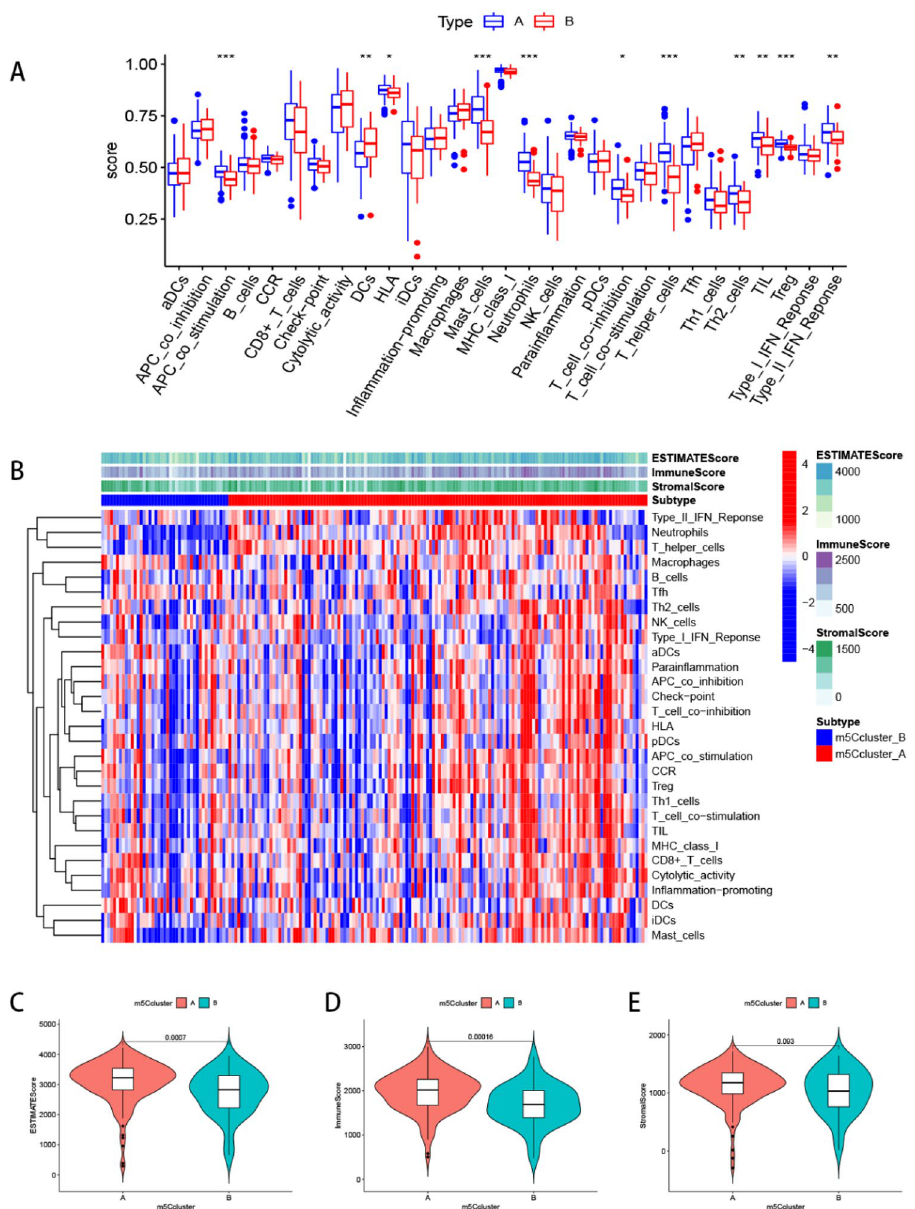
Figure 7. Single sample gene set enrichment analysis of the two m5Cclusters. ( A ) The boxplot of immune function in the two m5C patterns. * p < 0.05, ** p < 0.01, and *** p < 0.001. ( B ) The heatmap of immune function in the two m5C patterns. Other characteristics including estimate score, immune score, and stromal score. Differential estimate score ( C ), immune score ( D ), and stromal score ( E ) between m5Ccluster A and